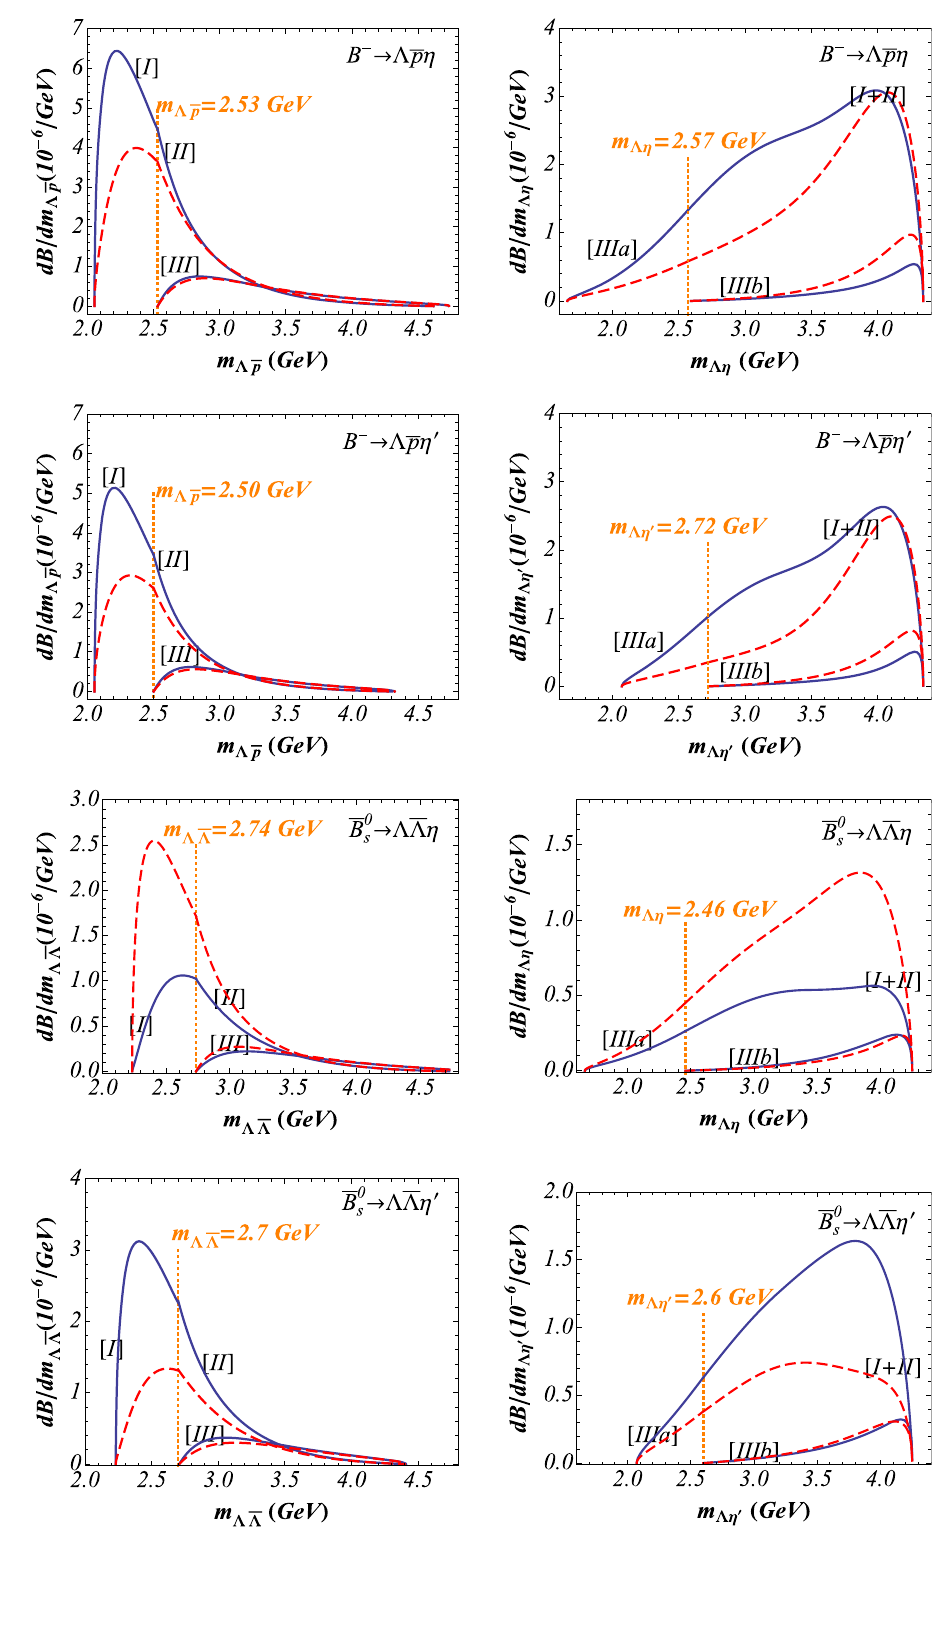
Fig. 4 Decay spectra versus m (left) and m B η ( (cid:3) ) (right) of B ¯ B (cid:3) the three-body B → B ¯ B (cid:3) η ( (cid:3) ) decays, where the solid (dash) curves for B − → (cid:3) ¯ p η with the constructive (destructive) interfering effects correspond to the kinematical regions in the left panel of Fig. 3, while those for B − → (cid:3) ¯ p η (cid:3) and ¯ B 0 → (cid:3) ¯ (cid:3)η ( (cid:3) ) are s